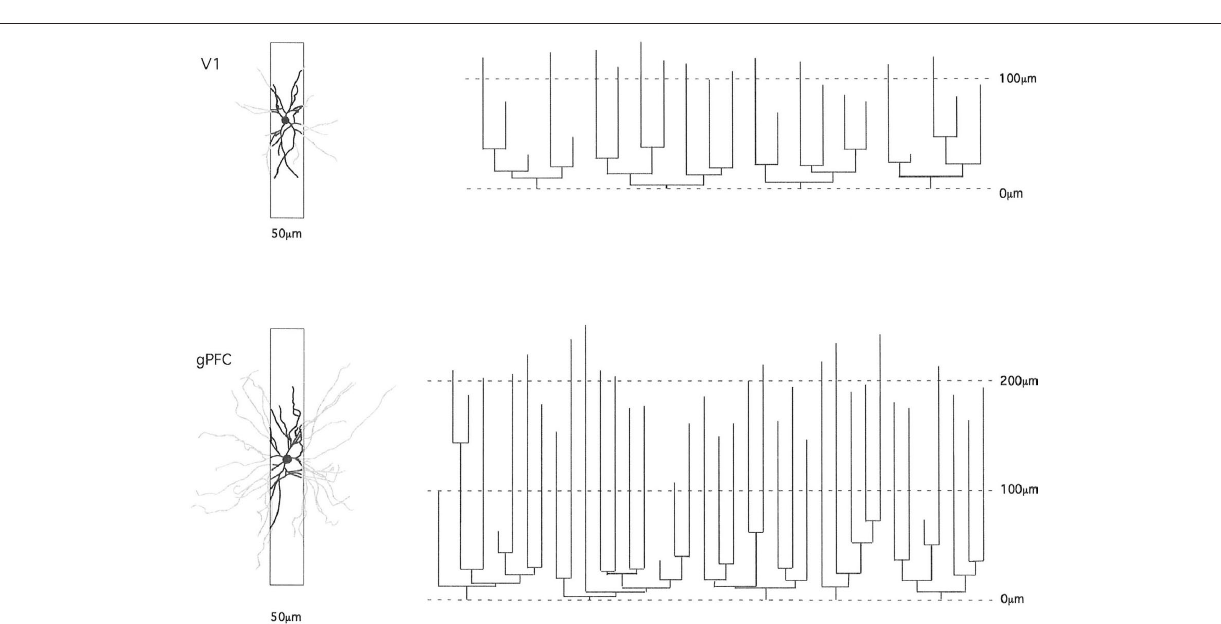
Figure 3 | Schematic illustrating how the study of pyramidal cell morphology in the transverse plane may bias for uniformity in structure. Illustrated are two cells sampled from the primary visual area (V1) and granular prefrontal cortex (gPFC) of the macaque monkey. At left are the basal dendritic trees of the two cells as seen in the tangential plane. In black is the part of the dendritic tree that would be seen in a 50-μm transverse section (of the type used in many Golgi studies). The portion of the dendrites extending beyond the